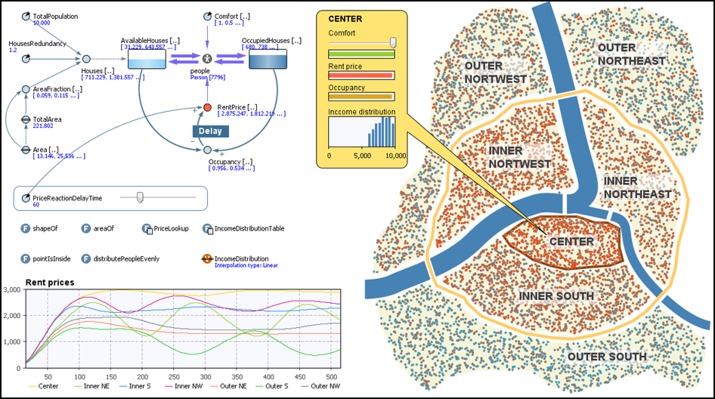
Example of an ABM-SD hybrid simulation model (AnyLogicTM).